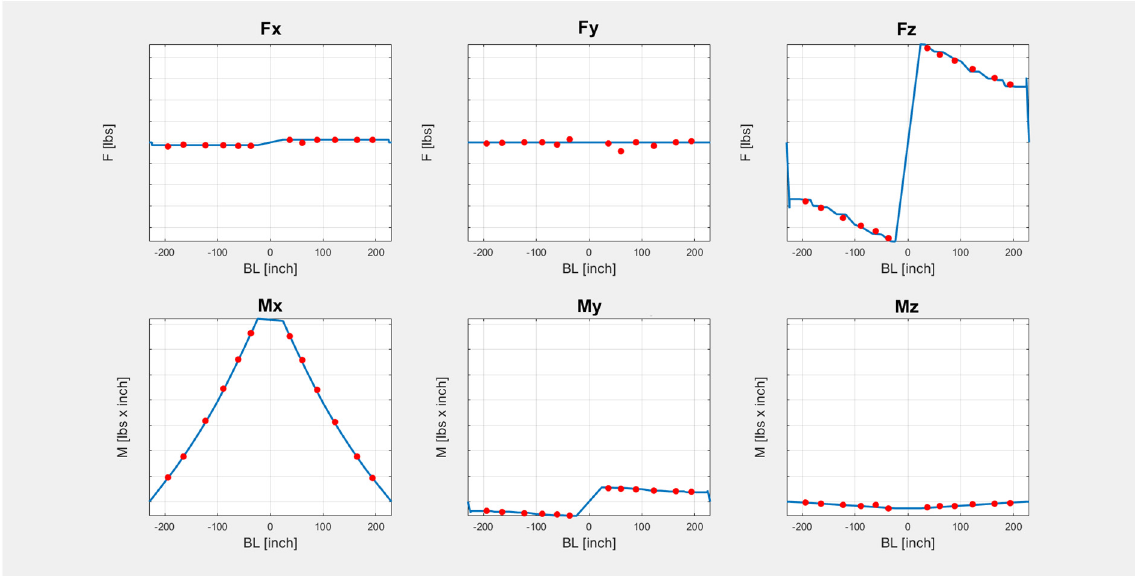
Figure 5. Taxi: shear, bending and torsion diagrams (COLD conditions).